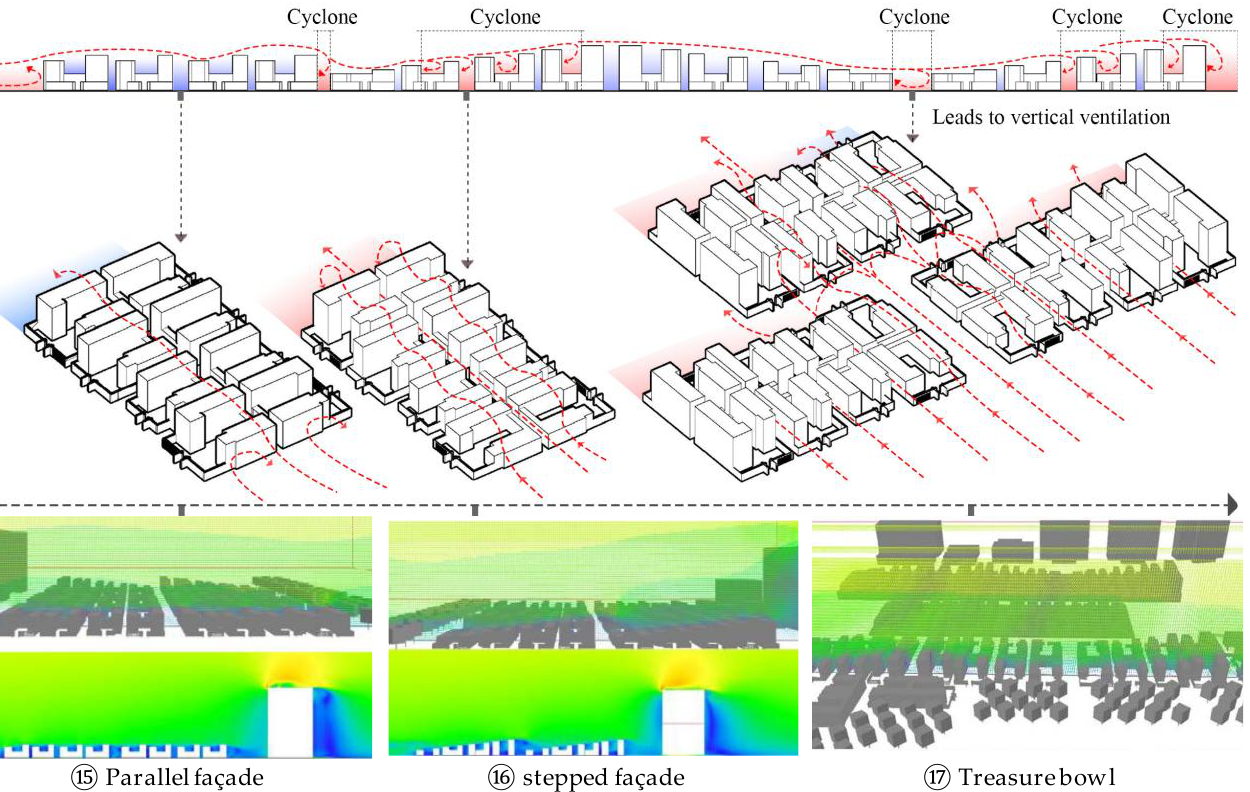
Figure 11. Optimization process of building façade combination and simulation results.